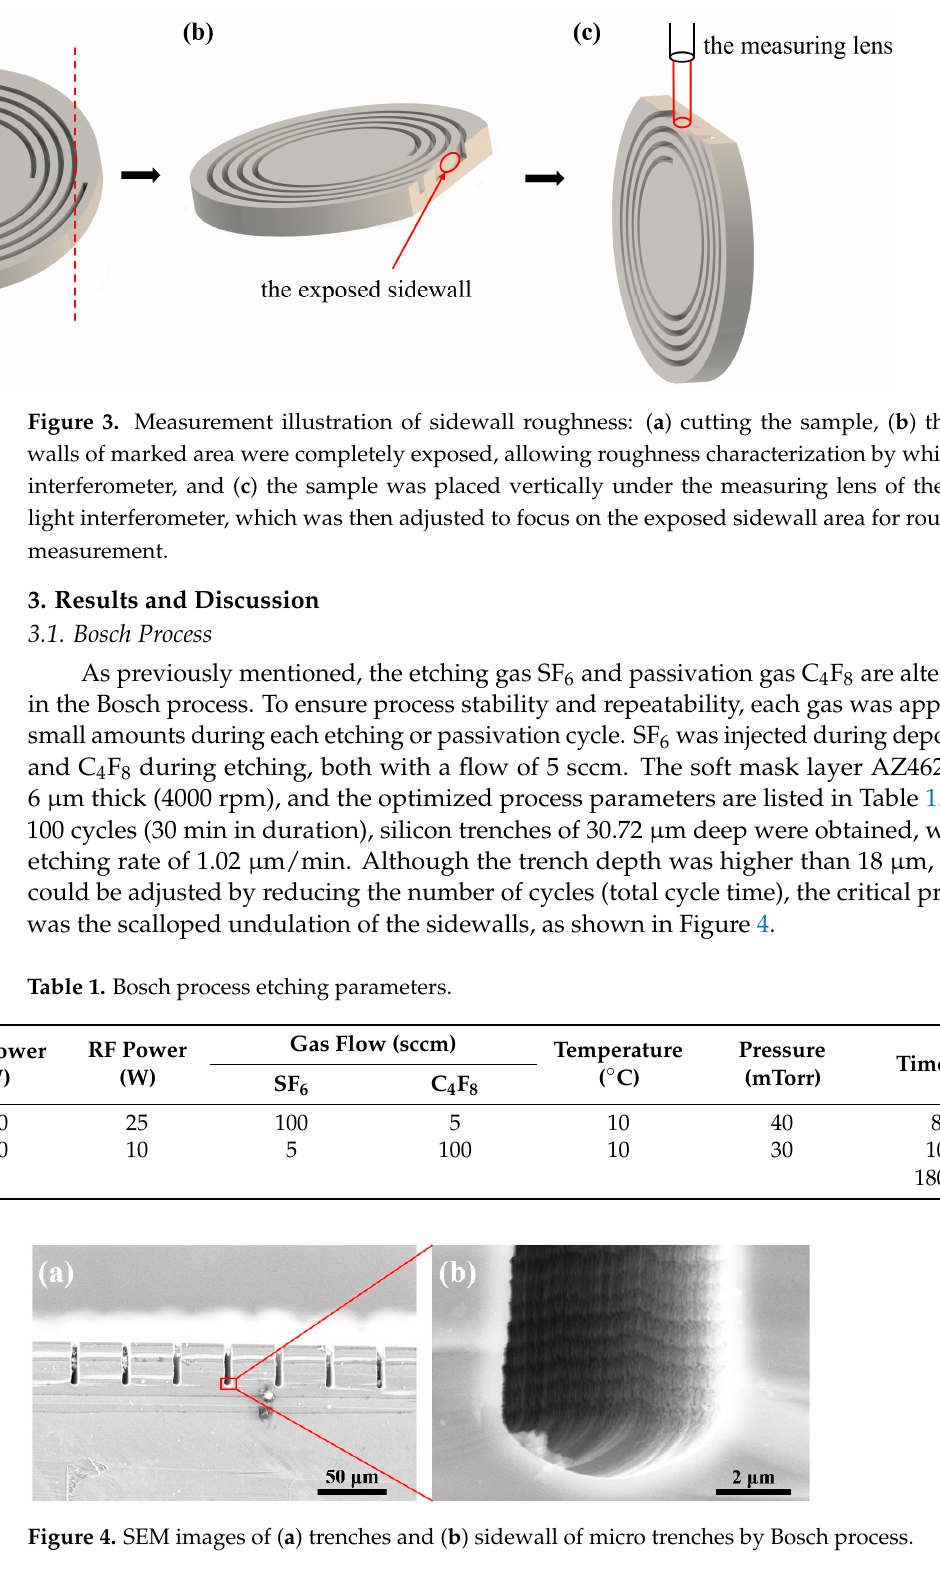
1.62 Figure 5. Different profiles of pseudo-Bosch experiments in ( a ) Group 1, ( b ) Group 2, ( c ) Group 3, ( d ) Group 4, and ( e ) Group 5.